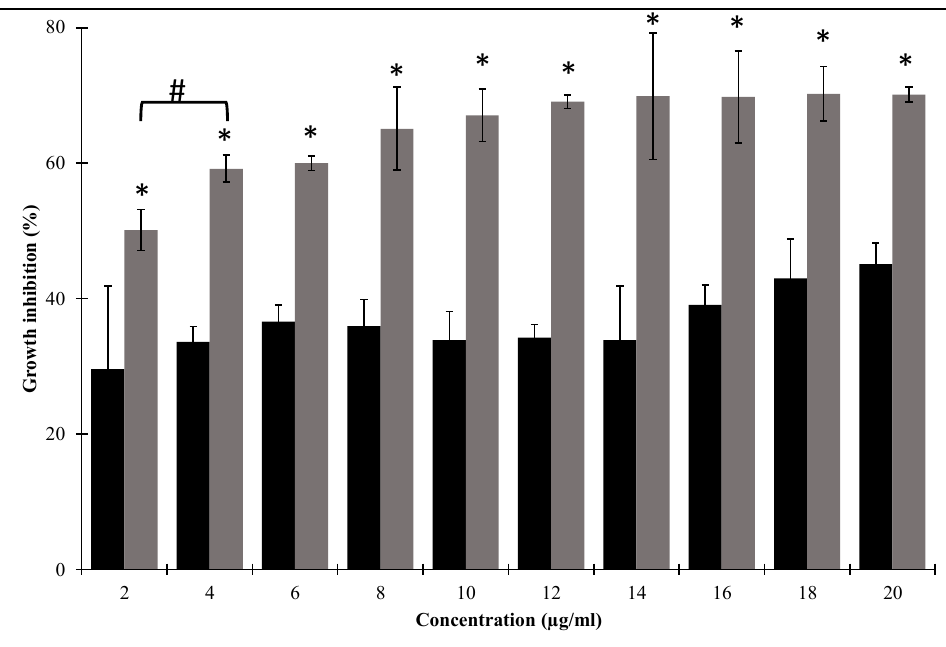
Figure 3. Growth inhibition analysis of combining HEWL with cecropin A (grey bars). Controls were conducted using cecropin A alone (black bars). The bars represent the growth inhibition activity of 500 µ g/mL of HEWL combined with cecropin A concentration range (2–4 µ g/mL) against Salmonella enterica ATCC 35664. Each value represents the mean ± standard deviation from three independent replicates. Asterisks represent the statistical differences from the values for cecropin A-treated cells (Student’s t test; * p < 0.05). # represents statical difference between mean values of HEWL/cecropin combinations containing 2 and 4 µ g/mL cecropin